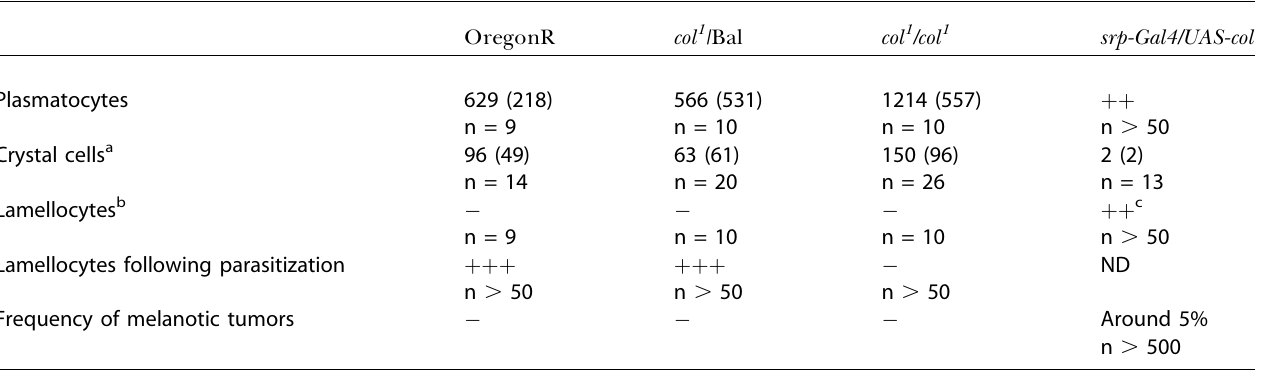
Table 1. Circulating Hemocytes in Third Instar